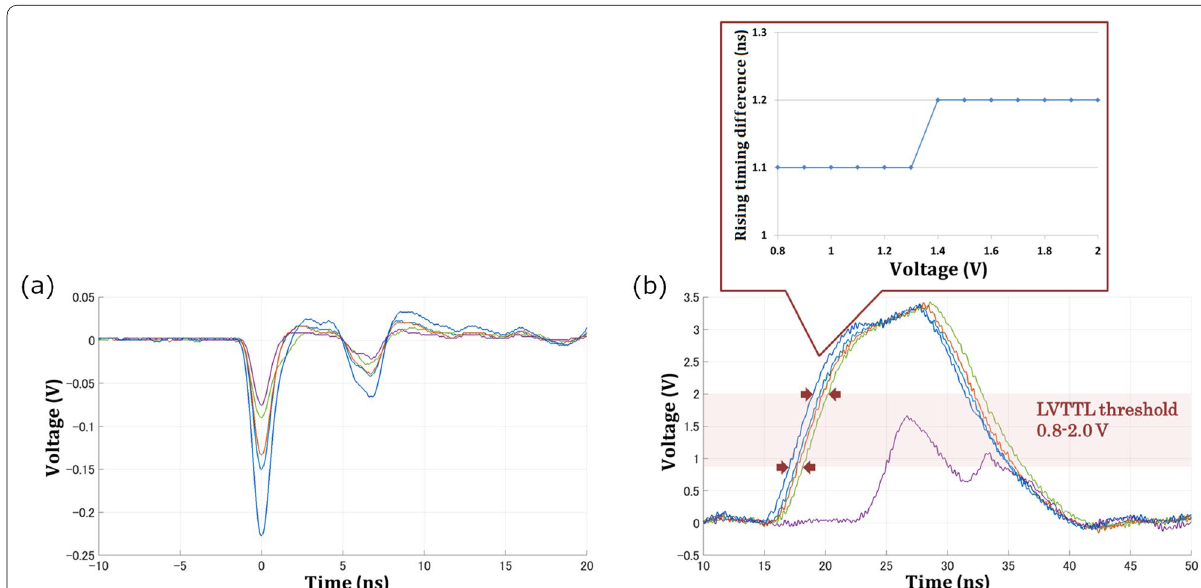
Fig. 8 Measured response of the comparator. Waveforms were measured at the monitoring points (see Fig. 6). a Input pulse measured at CHIP IN and b output waveform measured at COMPARATOR OUT. The time axis is defined so that the peak timing of the input waves is at 0 s. Each waveform in panel b corresponds to the waveform of the same color in panel a . In the threshold voltage range of LVTTL, the rising timing difference of the comparator output waveforms fluctuates by up to